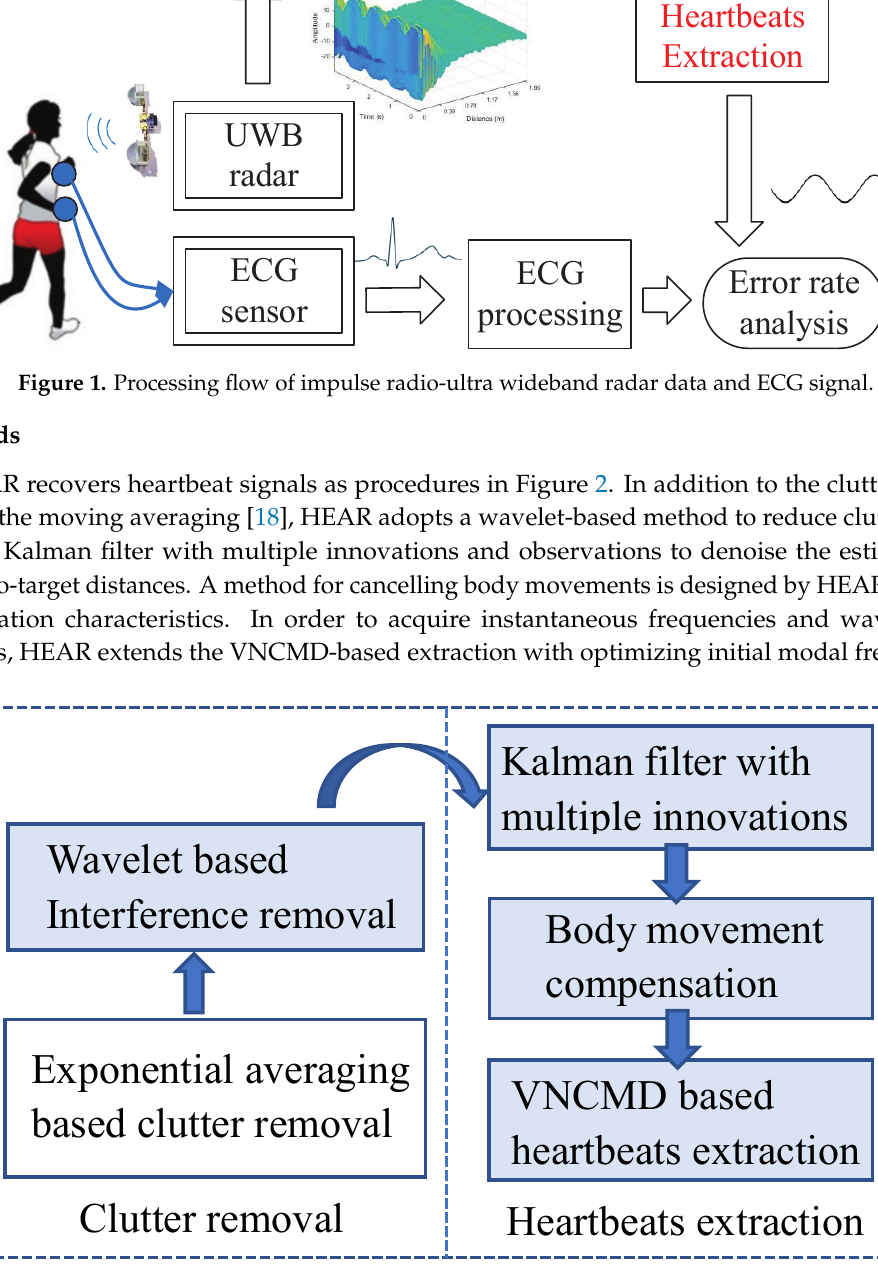
Figure 2. Flow of clutter removal and heartbeat extraction in Heartbeat Estimation and Recovery